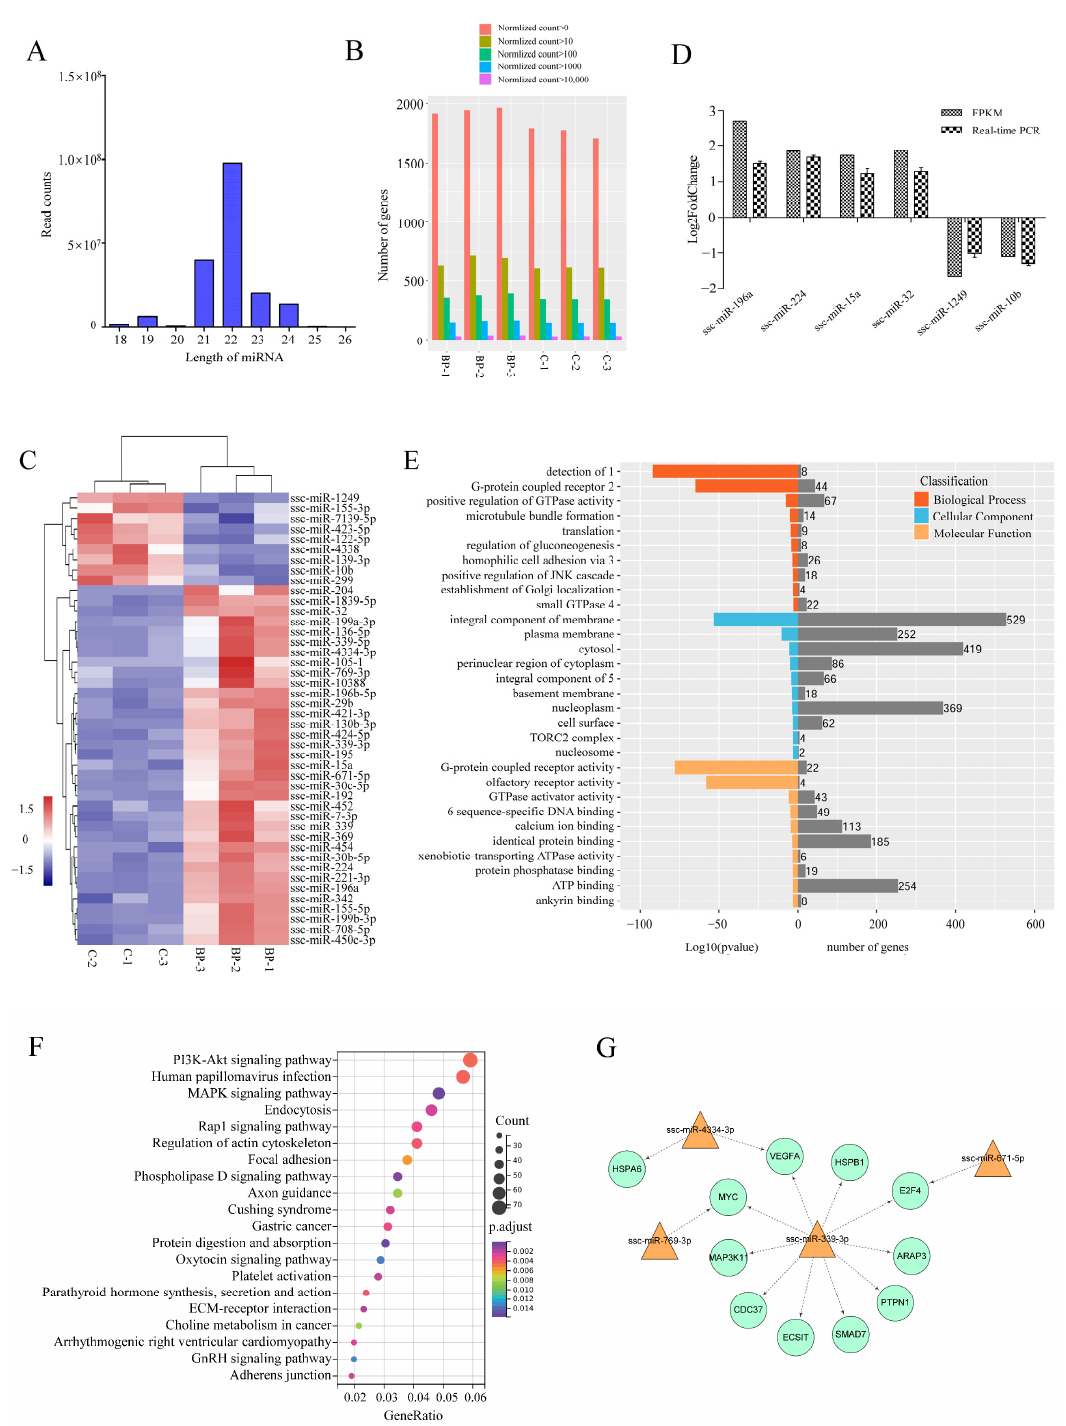
Figure 7. Characterization of differentially expressed miRNAs (DEmiRs) induced by BCL2L2- PABPN1. ( A ) Length distribution of miRNAs among six samples. ( B ) Barplot profiling the expression levels of the miRNAs in each sample. ( C ) Heatmap cluster of known DemiRs. ( D ) Validation of Illumina data with real-time PCR. ( E ) GO enrichment of target genes of DEmiRs. 1, detection of chemical stimulus involved in sensory perception of smell; 2, G-protein coupled receptor signaling pathway; 3, homophilic cell adhesion via plasma membrane adhesion molecules; 4, small GTPase mediated signal transduction; 5, integral component of plasma membrane; 6, RNA polymerase II core promoter proximal region sequence-specific DNA binding. ( F ) KEGG enrichment of target genes of DEmiRs. ( G ) Fat-related miRNA-mRNA interaction